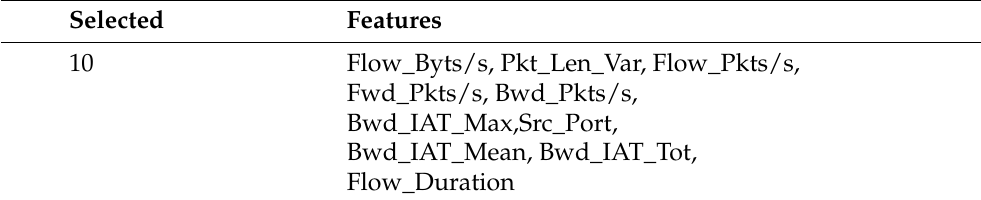
Table 4. Configuration parameters of the